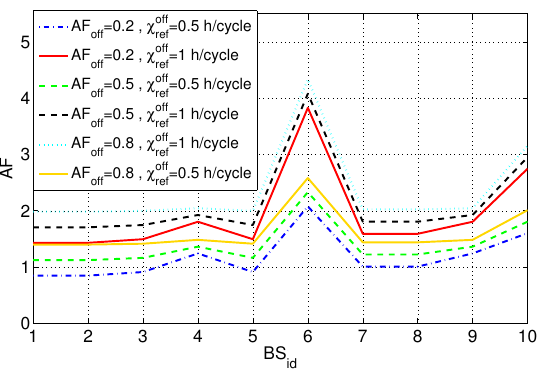
Figure 11. AF for the single BSs for the LTE scenario.